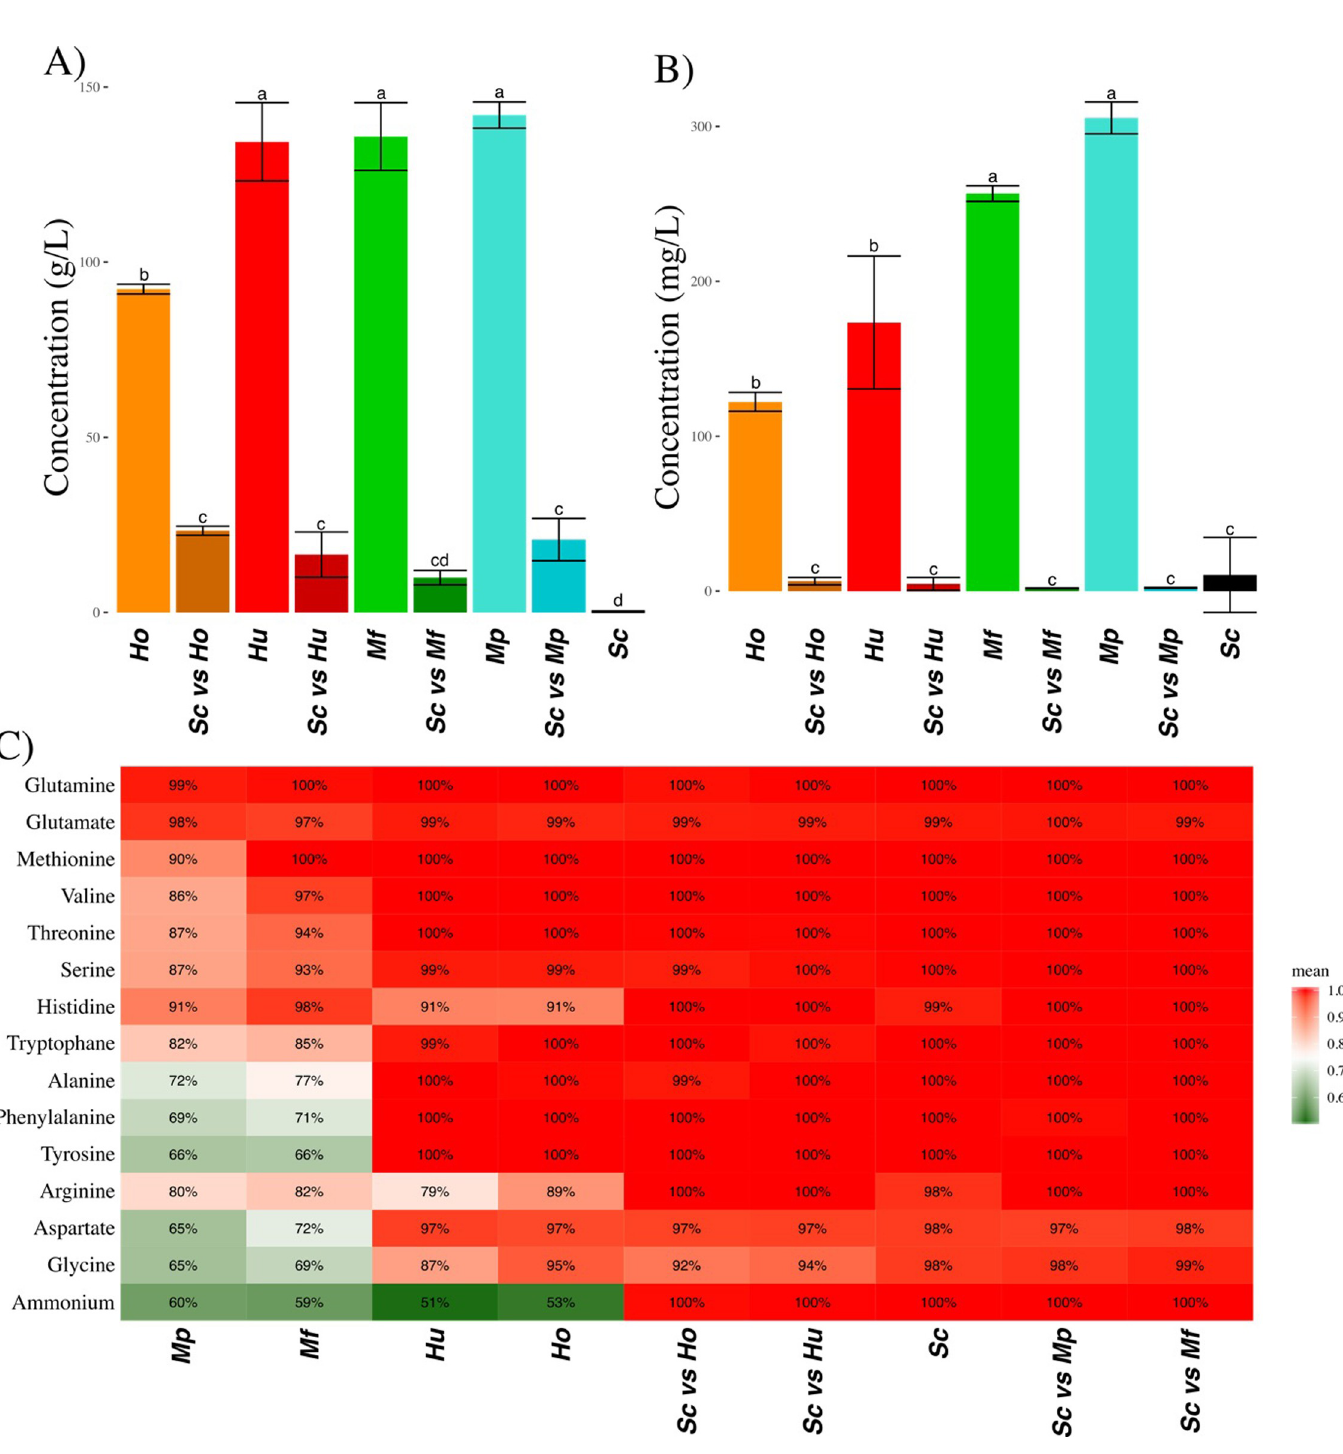
Fig 3. Consumption of sugars and nitrogen assimilable sources (NAS) for each type of fermentation. A) Final concentration of sugar (average ± standard deviation). B) Final concentration of NAS (average ± standard deviation). C) Percentage of consumption of each NAS in each type of fermentation represented as a color gradient from green ( < 75%) to red ( >